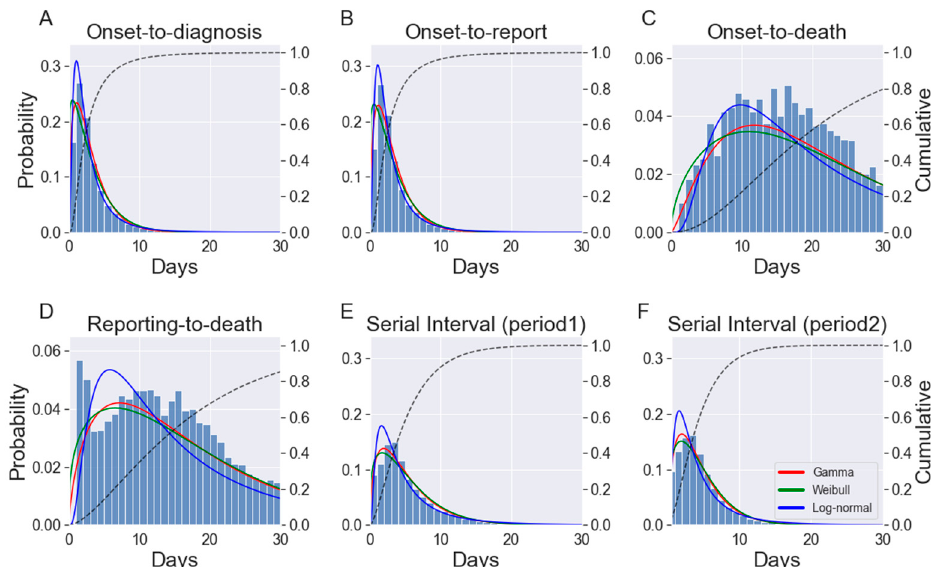
Figure 2. Histograms and the distribution of: ( A ), onset-to-diagnosis; ( B ), onset-to-report; ( C ), onset- to-death; ( D ), reporting-to-death; ( E ), serial intervals in Period 1; and ( F ), serial intervals in Period 2. Note: Solid lines indicate fitted PDFs; dashed lines show the cumulative distribution function of the best-fitting PDF. The y -axis on the left-hand side shows the probability value of the PDFs, and the y -axis on the right-hand side shows the value of the cumulative distribution function. All values on the x -axis are presented in days. PDF, probability density functions.